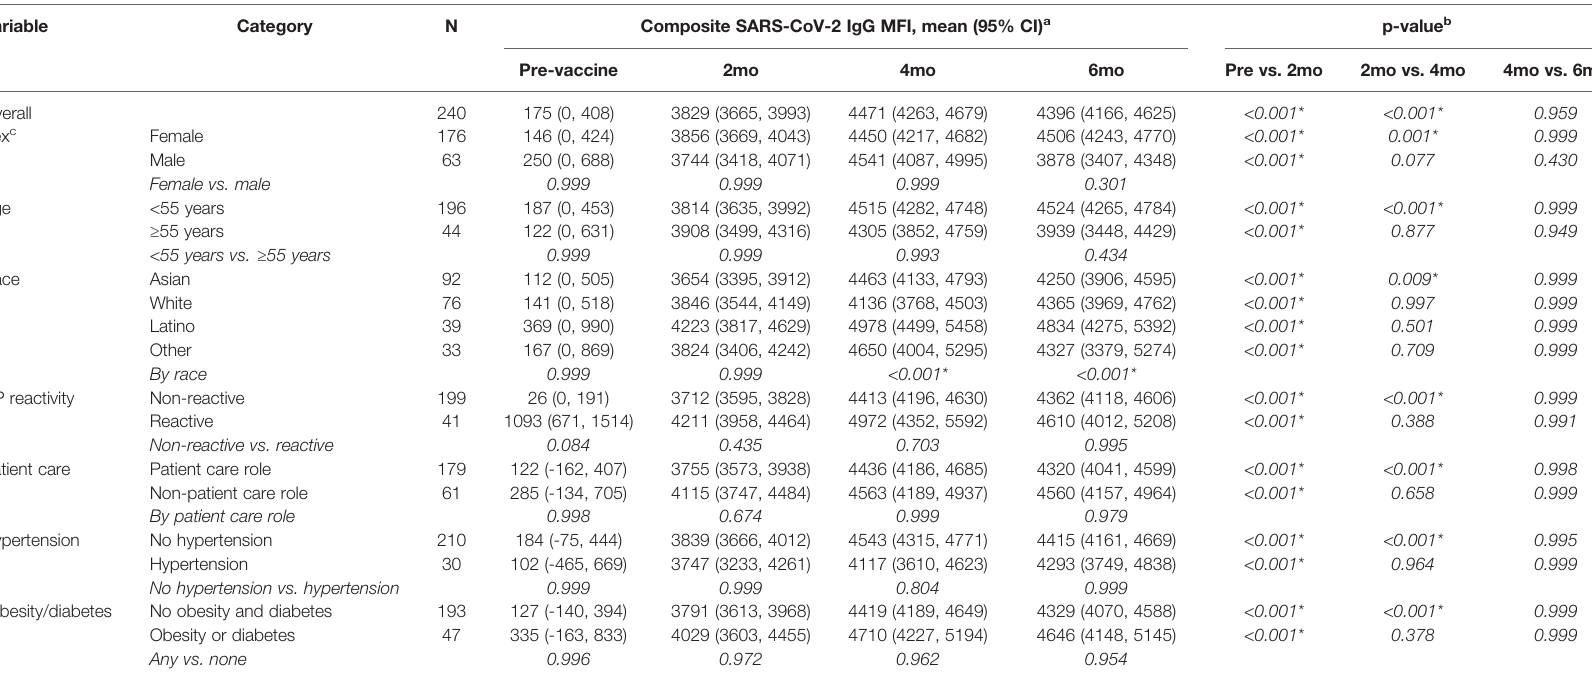
TABLE 2 | Composite SARS-CoV-2 IgG levels compared between time points for subgroups of study participants divided by gender, age, race, occupation role, and presence of co-morbidities. Variable